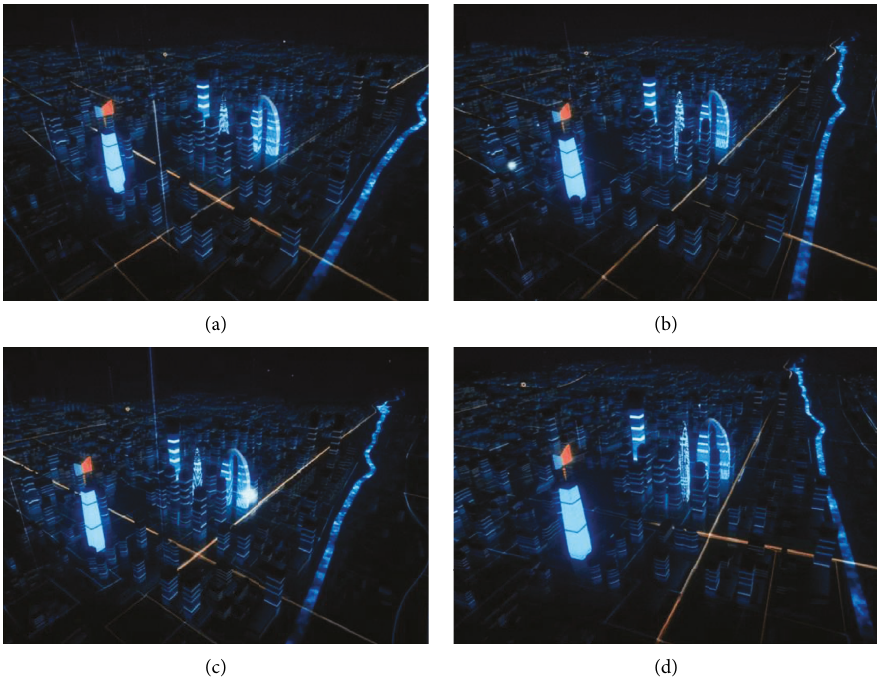
Figure 9: Smart city simulation